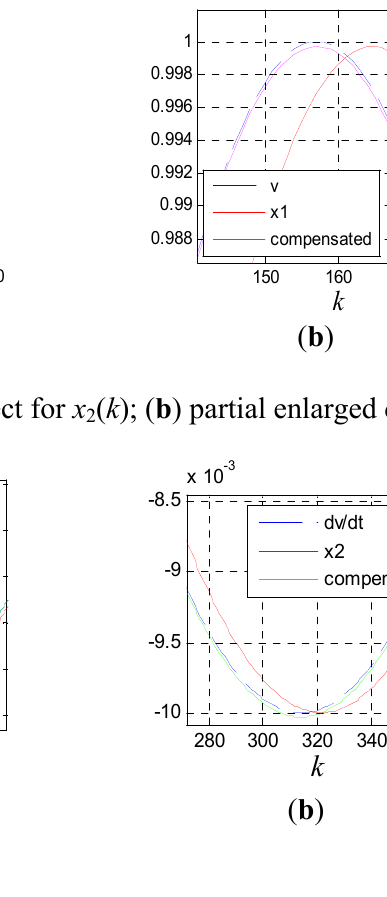
( k ); ( b ) partial enlarged drawing of (a). 1